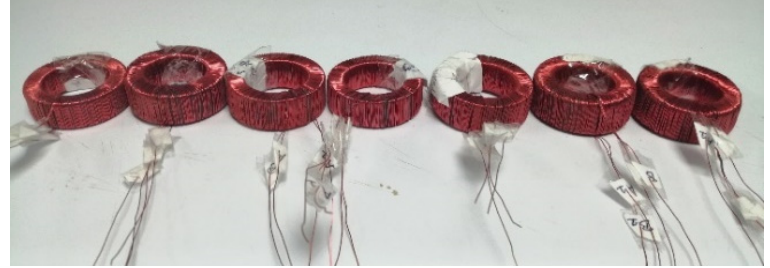
Figure 5. Inductors with the same number of turns in the primary and secondary windings.